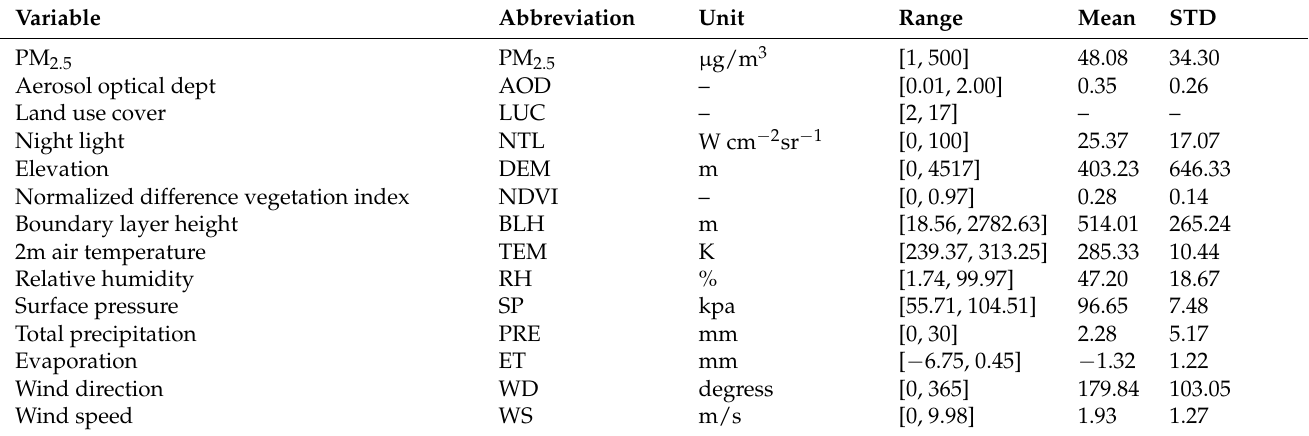
Table 1. Statistics of collected features after data cleaning, including unit, range, mean, and standard deviation